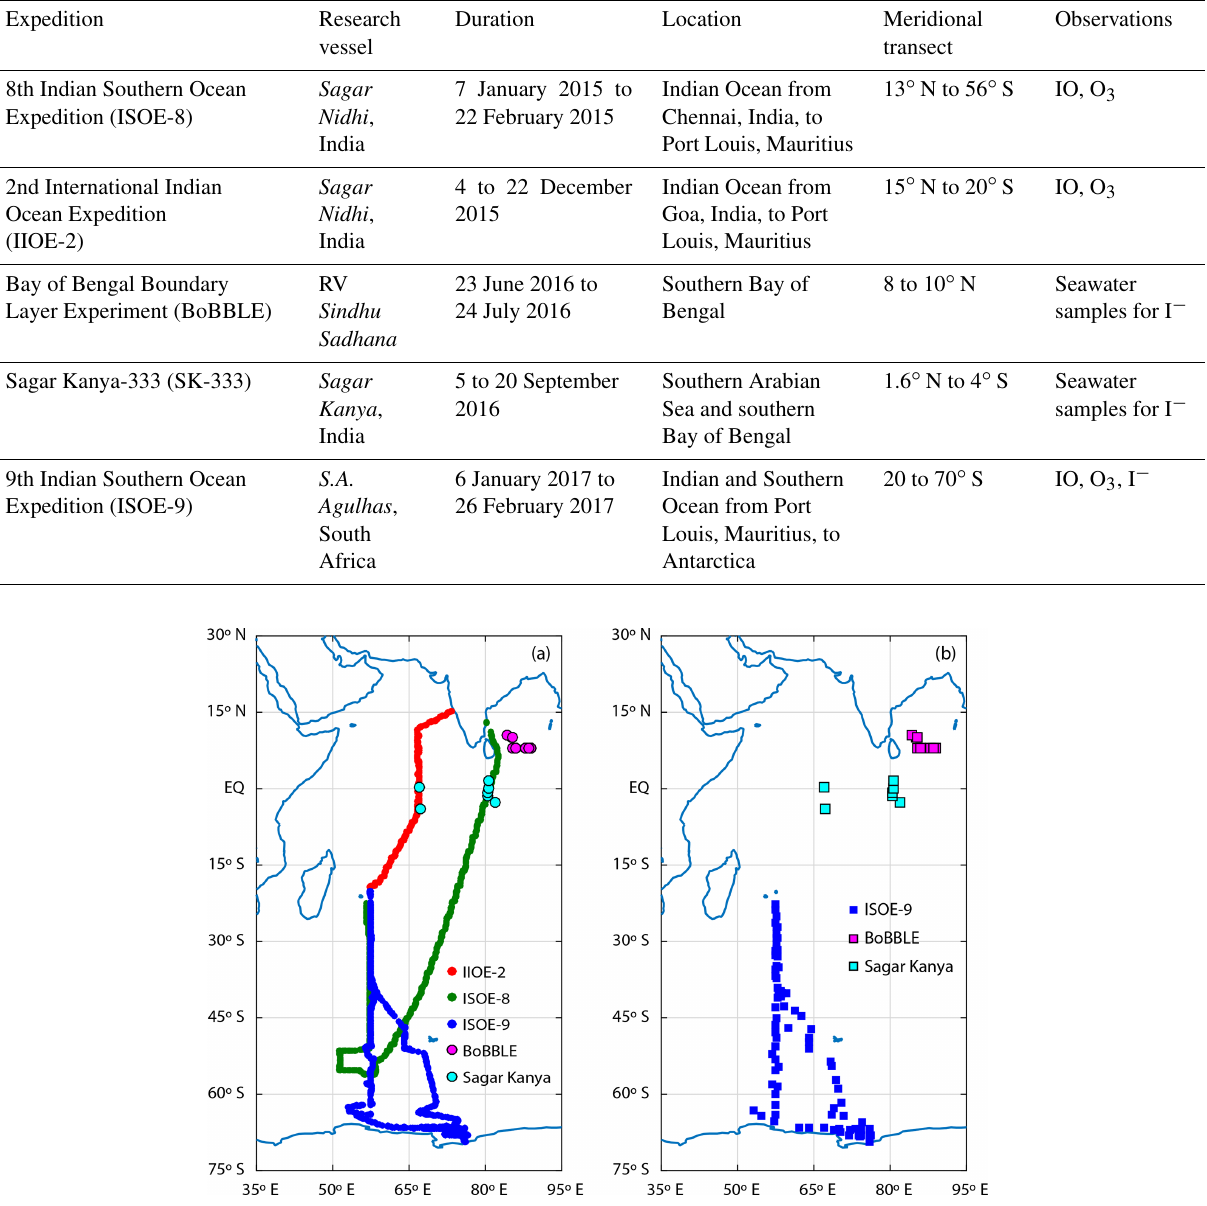
Table 1. Details of the three expeditions contributing to the IO and seawater iodide dataset in this study. Expeditions are listed in chronological order from 2015 to 2017.